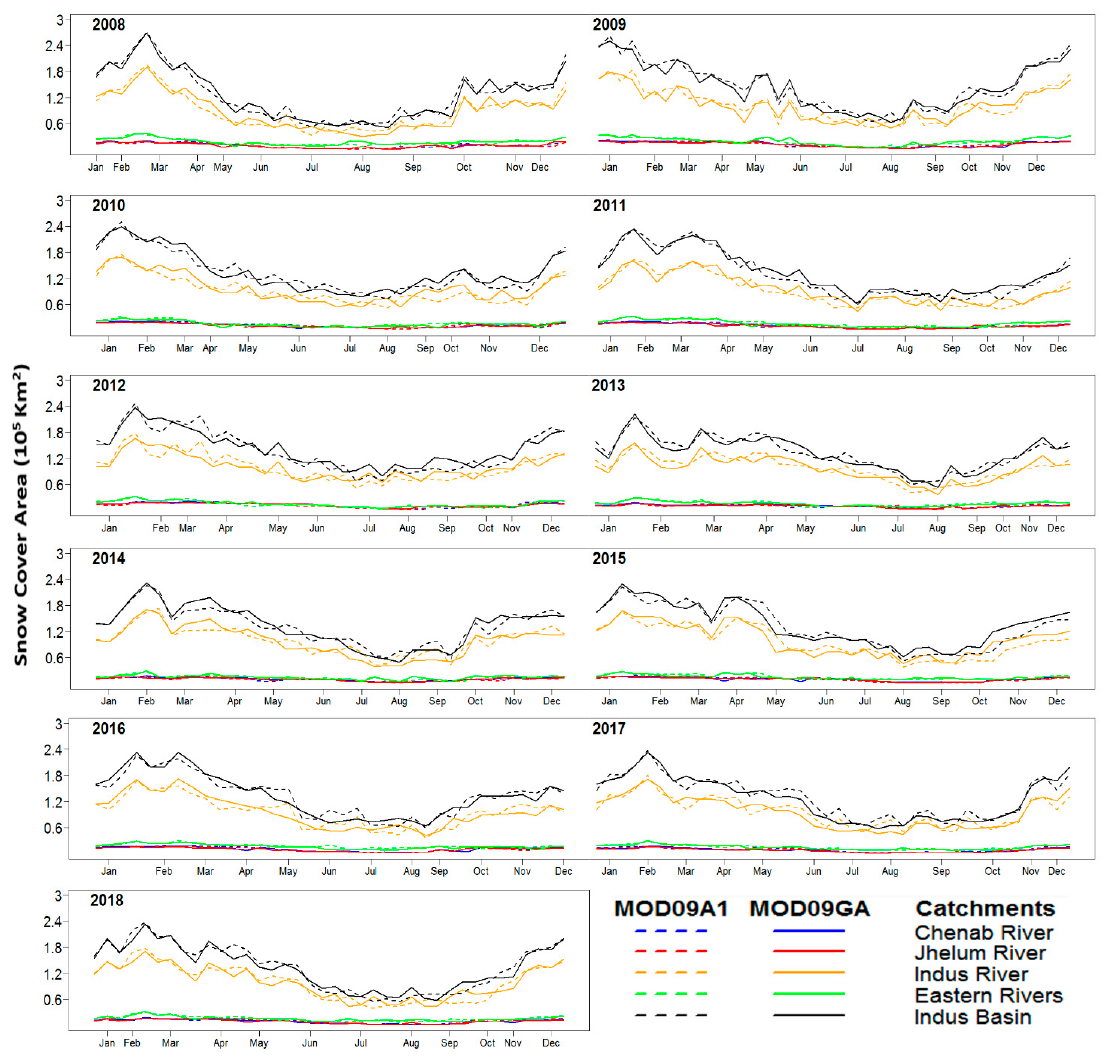
Figure 6. Annual time series trends of snow cover area estimated using MODIS MOD09GA and MOD09A1 products for the Indus basin and its rivers’ catchments.